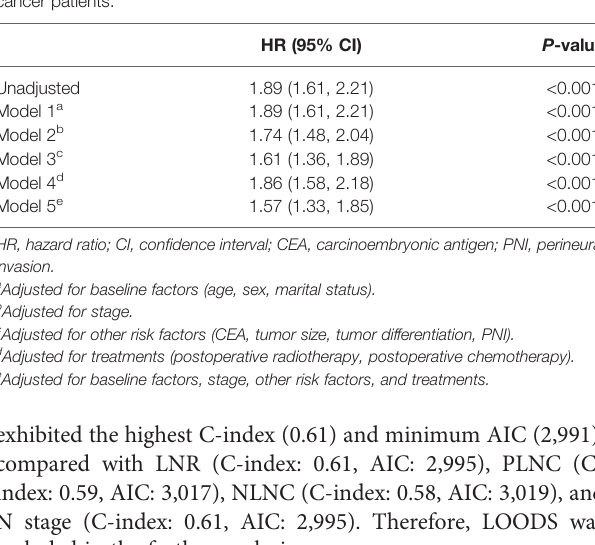
TABLE 2 | Effect of pretreatment tumor deposits on overall survival in rectal cancer